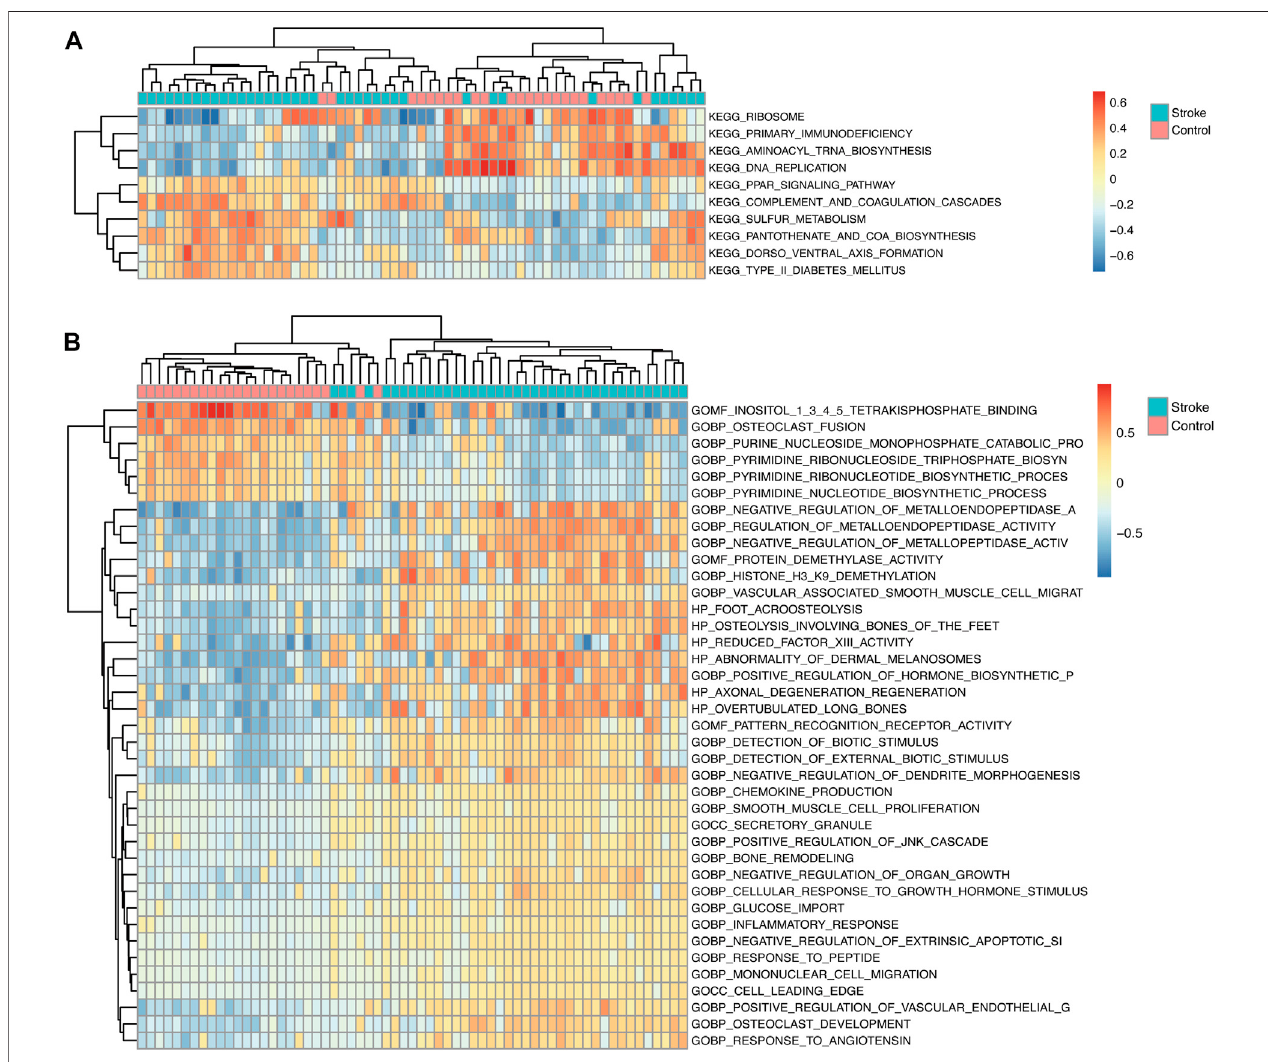
FIGURE 8 | GSVA analysis. (A) In the GSVA enrichment analysis of KEGG term entries, the color scale represents the abundance of gene expression, red represents up-regulation, and blue represents down-regulation. The darker the color shade, the higher is the expression level. (B) GSVA analysis of GO term entries.